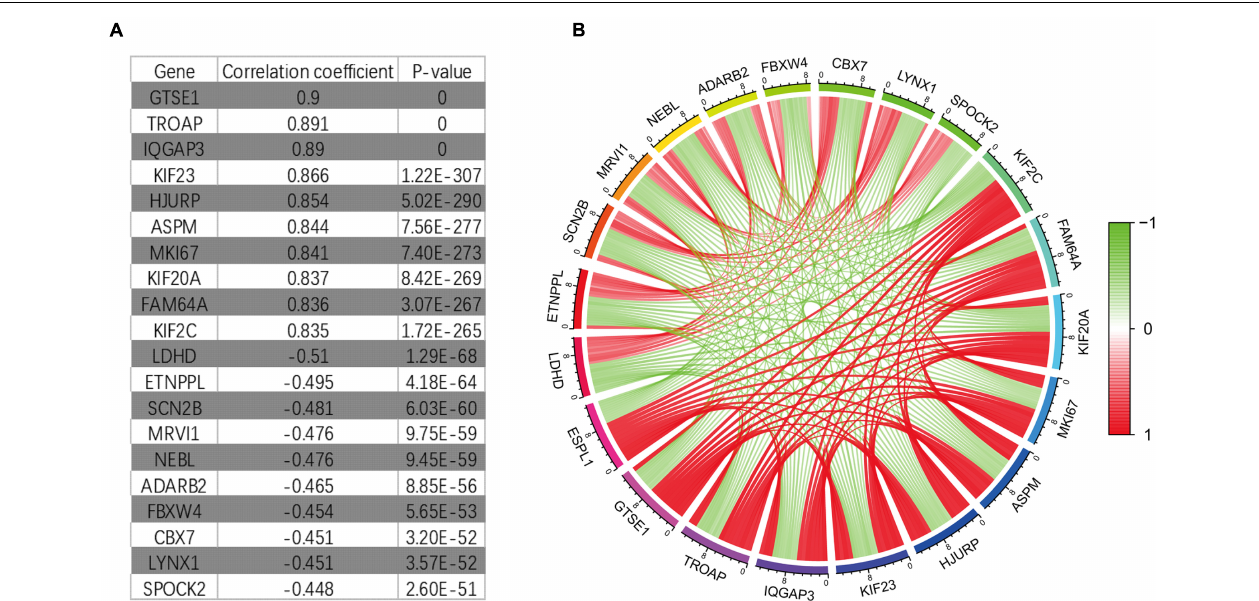
FIGURE 8 | It co-expresses the analysis results. (A) Some genes that have synergistic and antagonistic effects with ESPL1, including their names, correlation coefficient values, and p -values. (B) The expression relationship diagram of genes related to ESPL1.